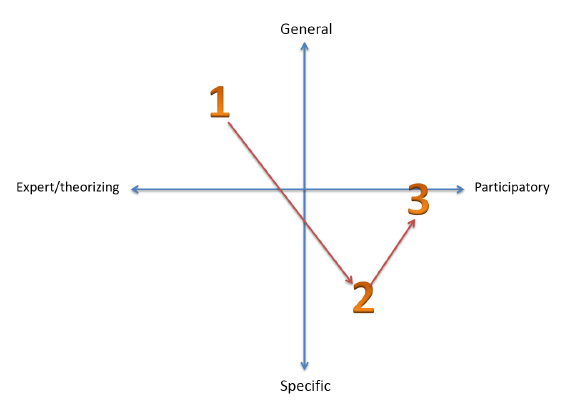
Fig. 3 . Chowdhury’s research